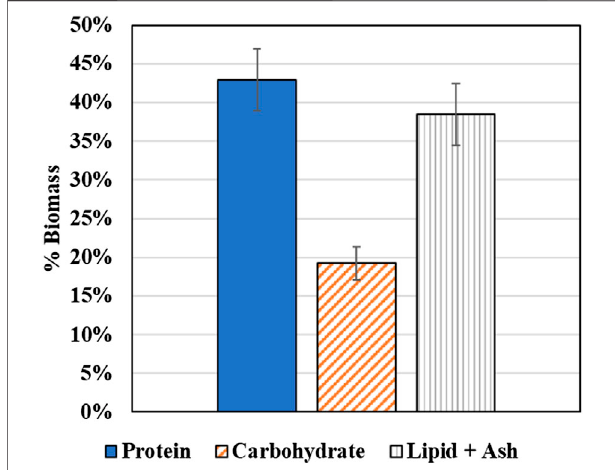
FIGURE 14 | Biochemical composition of the mixed coculture